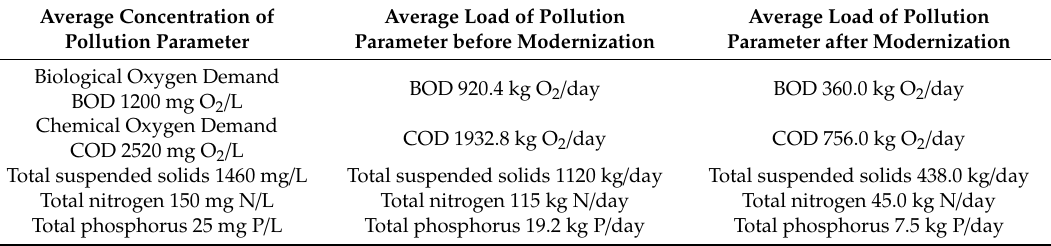
Table 2. Contamination indicators for raw sewage flowing into the treatment plant in Wydminy before and after